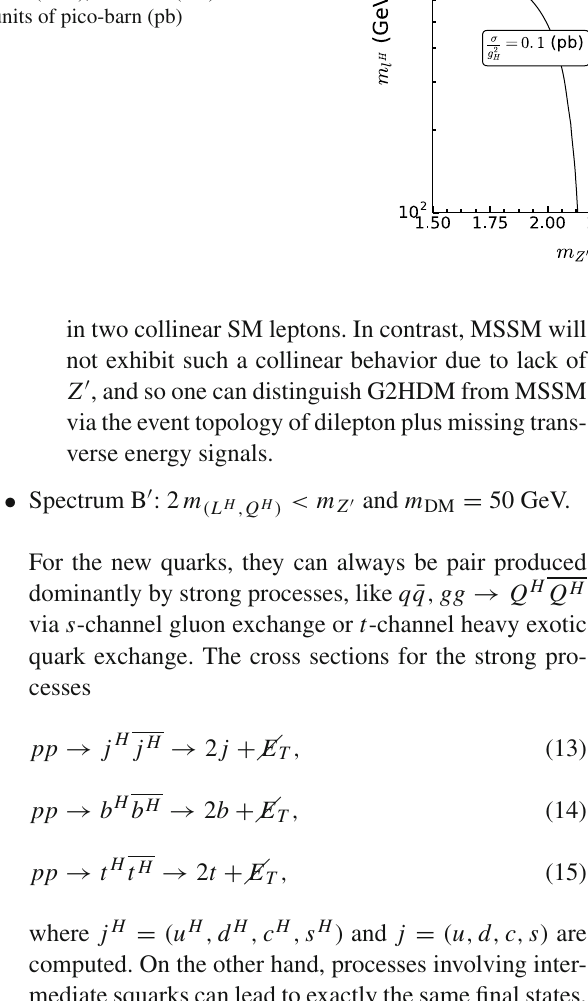
Fig. 2 The cross section contours for Spectrum A (cid:2) at √ s = 14TeV on the m Z (cid:2) – m l H and m Z (cid:2) – m τ H planes. Three benchmark values are shown = 0 . 1 (black), here: σ g 2 H 0 . 05 (blue), and 0 . 01 (red) in units of pico-barn